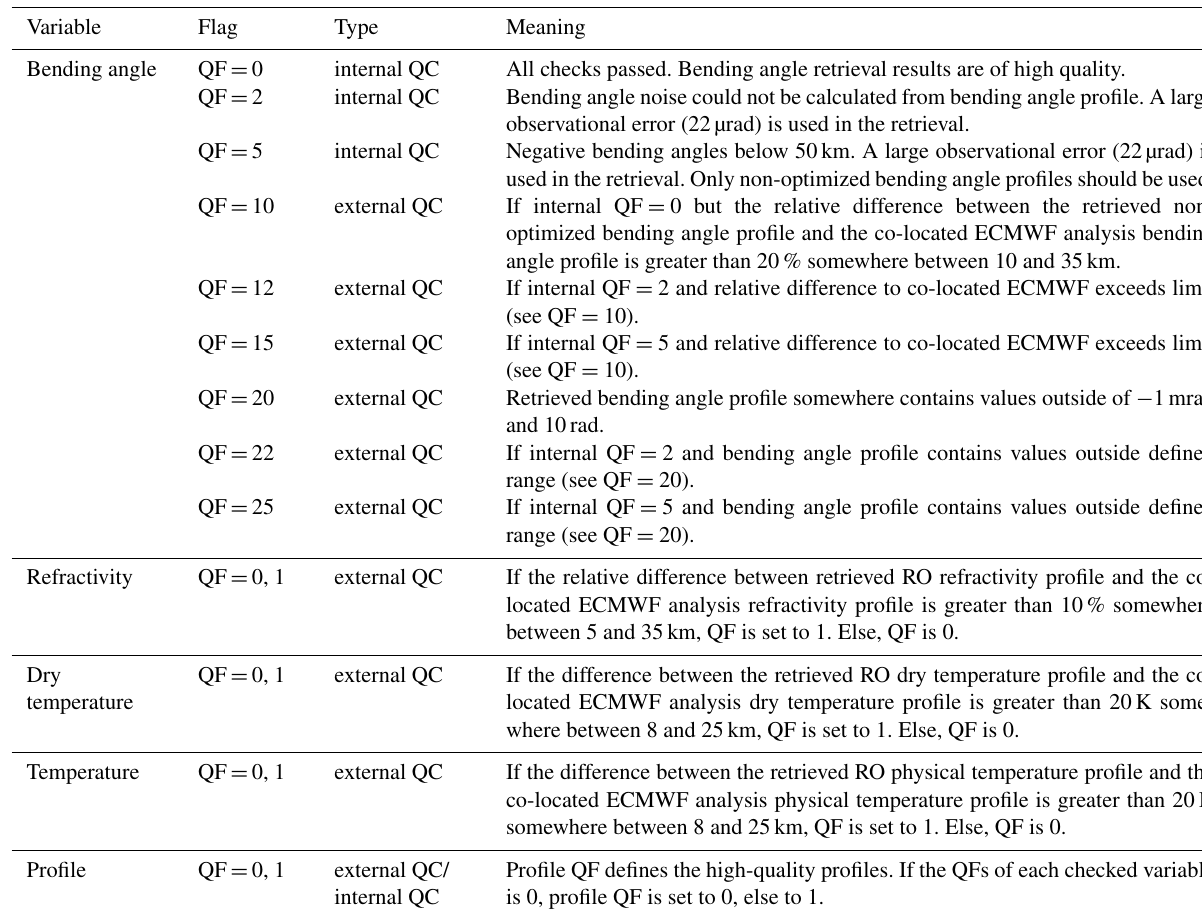
Table 2. Quality flags (QFs) defined within the WEGC OPSv5.6 data processing. Variable Flag Type Meaning Bending angle QF = 0 internal QC All checks passed. Bending angle retrieval results are of high quality. QF = 2 internal QC Bending angle noise could not be calculated from bending angle profile. A large observational error (22µrad) is used in the retrieval. QF = 5 internal QC Negative bending angles below 50km. A large observational error (22µrad) is used in the retrieval. Only non-optimized bending angle profiles should be used. QF = 10 external QC If internal QF = 0 but the relative difference between the retrieved non- optimized bending angle profile and the co-located ECMWF analysis bending angle profile is greater than 20% somewhere between 10 and 35km. external QC If internal QF = 2 and relative difference to co-located ECMWF exceeds limit (see QF = 10). If internal QF = 5 and relative difference to co-located ECMWF exceeds limit (see QF = 10). external QC Retrieved bending angle profile somewhere contains values outside of − 1mrad and 10rad. external QC If internal QF = 2 and bending angle profile contains values outside defined range (see QF = 20). QF = 25 external QC If internal QF = 5 and bending angle profile contains values outside defined range (see QF = 20). If the relative difference between retrieved RO refractivity profile and the co- located ECMWF analysis refractivity profile is greater than 10% somewhere between 5 and 35km, QF is set to 1. Else, QF is 0. If the difference between the retrieved RO dry temperature profile and the co- located ECMWF analysis dry temperature profile is greater than 20K some- where between 8 and 25km, QF is set to 1. Else, QF is 0. If the difference between the retrieved RO physical temperature profile and the co-located ECMWF analysis physical temperature profile is greater than 20K somewhere between 8 and 25km, QF is set to 1. Else, QF is 0. Profile QF defines the high-quality profiles. If the QFs of each checked variable is 0, profile QF is set to 0, else to